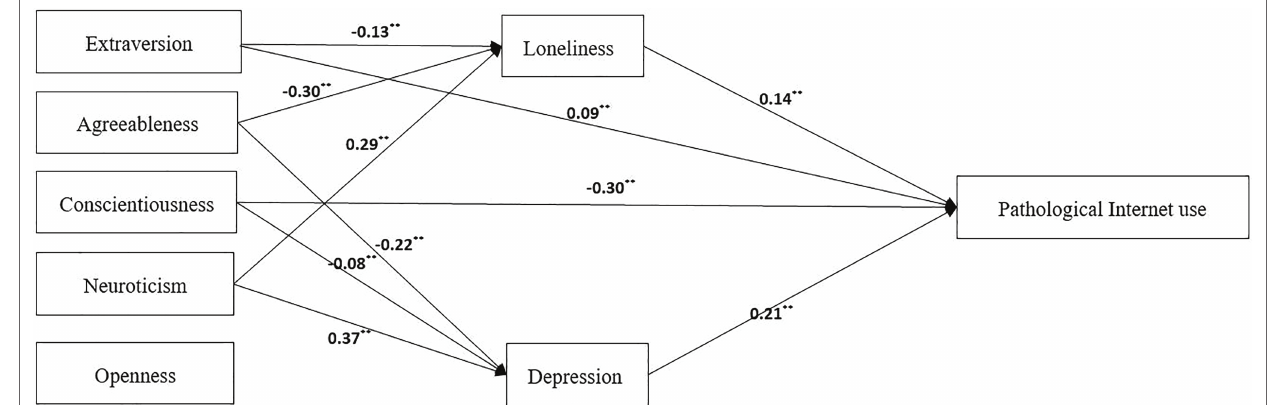
FIGURE 3 | Comparison model. **p < 0.01.